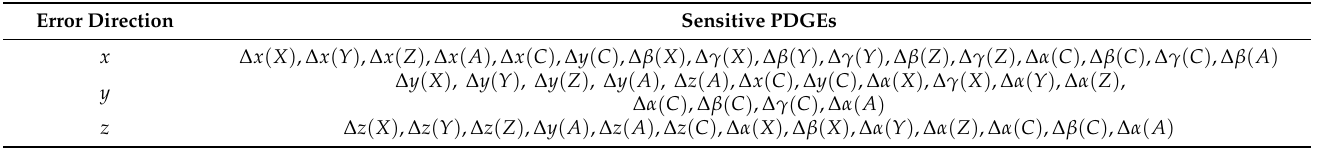
Table 2. Sensitive PDGEs in all